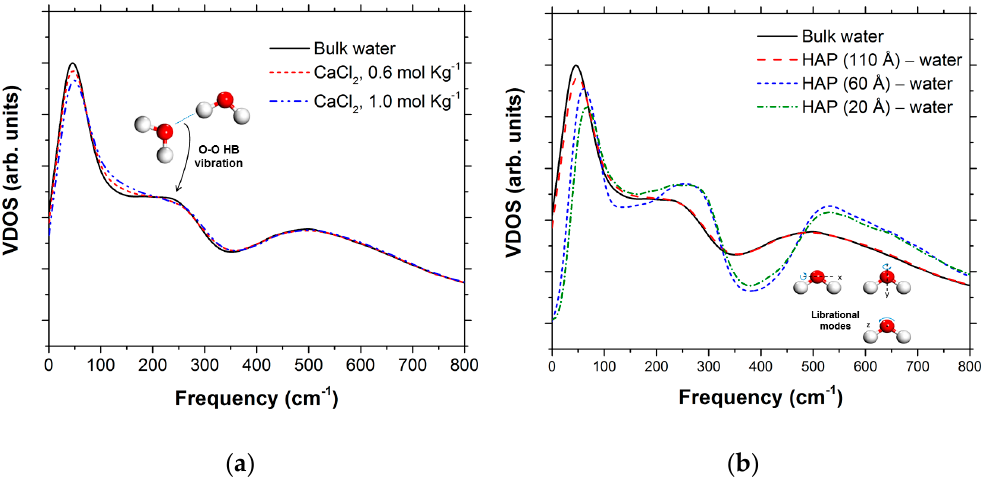
Figure 5. Total vibrational density of states for the water molecules obtained from the sum of the Fourier transform of the velocity autocorrelation function of the oxygen and hydrogen atoms. ( a ) Bulk water and aqueous CaCl 2 solutions. ( b ) Bulk water and water within HAP nanopores (H = 60 Å and H = 20 Å).